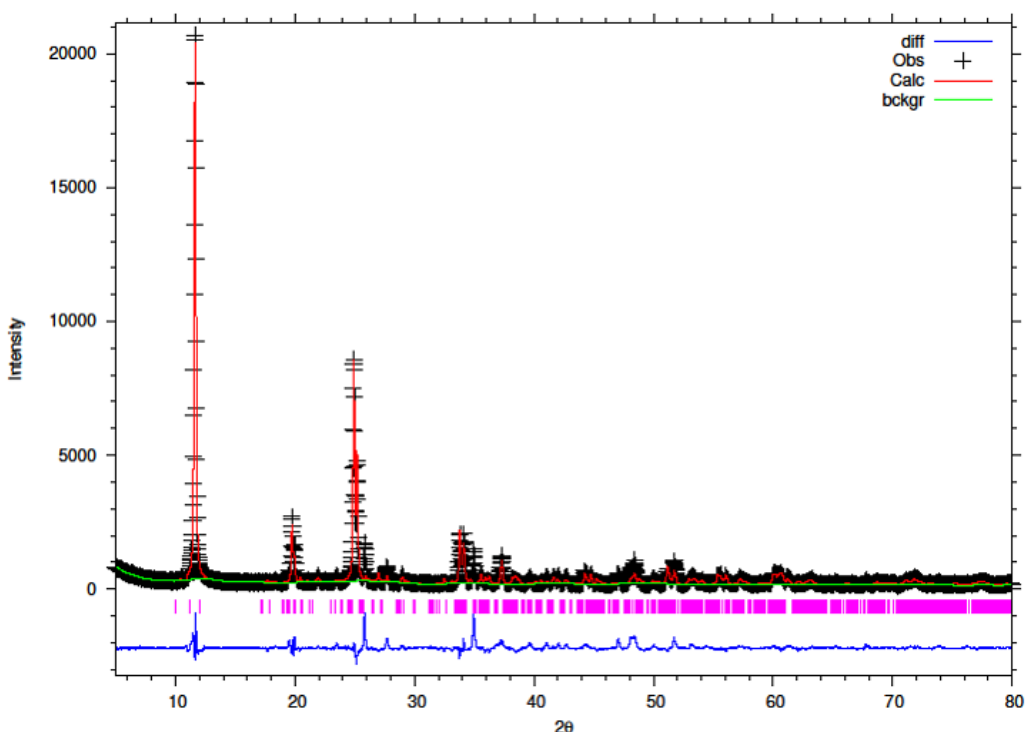
Figure 15. Final observed (cross), calculated (red line) and difference (blue bottom) Rietveld plots for 15% Y-ZrP. Therefore, it was of interest to analyse the lattice parameters order to determine if the substitution of zirconium with yttrium followed the Vegard’s law. The unit cell constants (a,b,c) along with the volume and average bond distances are plotted for both refluxed and hydrothermally synthesised Y–ZrP samples in Figures 16 and 17.